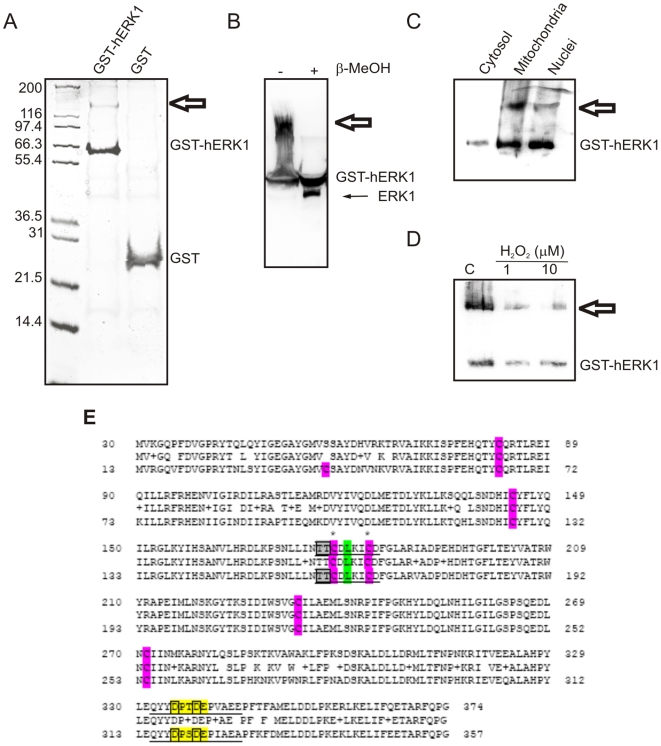
ERK dimer formation in mitochondria.(A) Pulldown assay and electrophoresis as in Fig. 2. Samples were run in the absence of β-ME or DTT. Molecular weight markers displayed on the right. Thick arrow, GST-hERK1 dimer. (B) Recombinant hERK1-GST immobilized on GSH-agarose incubated with mitochondria with dimerization evaluated by western blotting in the presence or absence of β−ME. Thin arrow, endogenous ERK, recovered from the dimer upon incubation with β−ME. (C) hERK1-GST recombinant protein immobilized on GSH-agarose and incubated with mitochondrial, cytosolic or nuclear fractions. hERK1-GST and hERK1-GST dimer detected by western blot. (D) GST-hERK1 recombinant protein oxidized with different H2O2 concentrations and processed as in (C). Dimerization evaluated by western blotting. (E) Alignment of ERK1 (top) and ERK2 (bottom) amino acid sequences. CD domain (yellow), ED domain (grey), dimerization site (green) [34], [35], cysteines (purple) and cysteines (*) putatively involved in disulfide bond formation are highlighted.